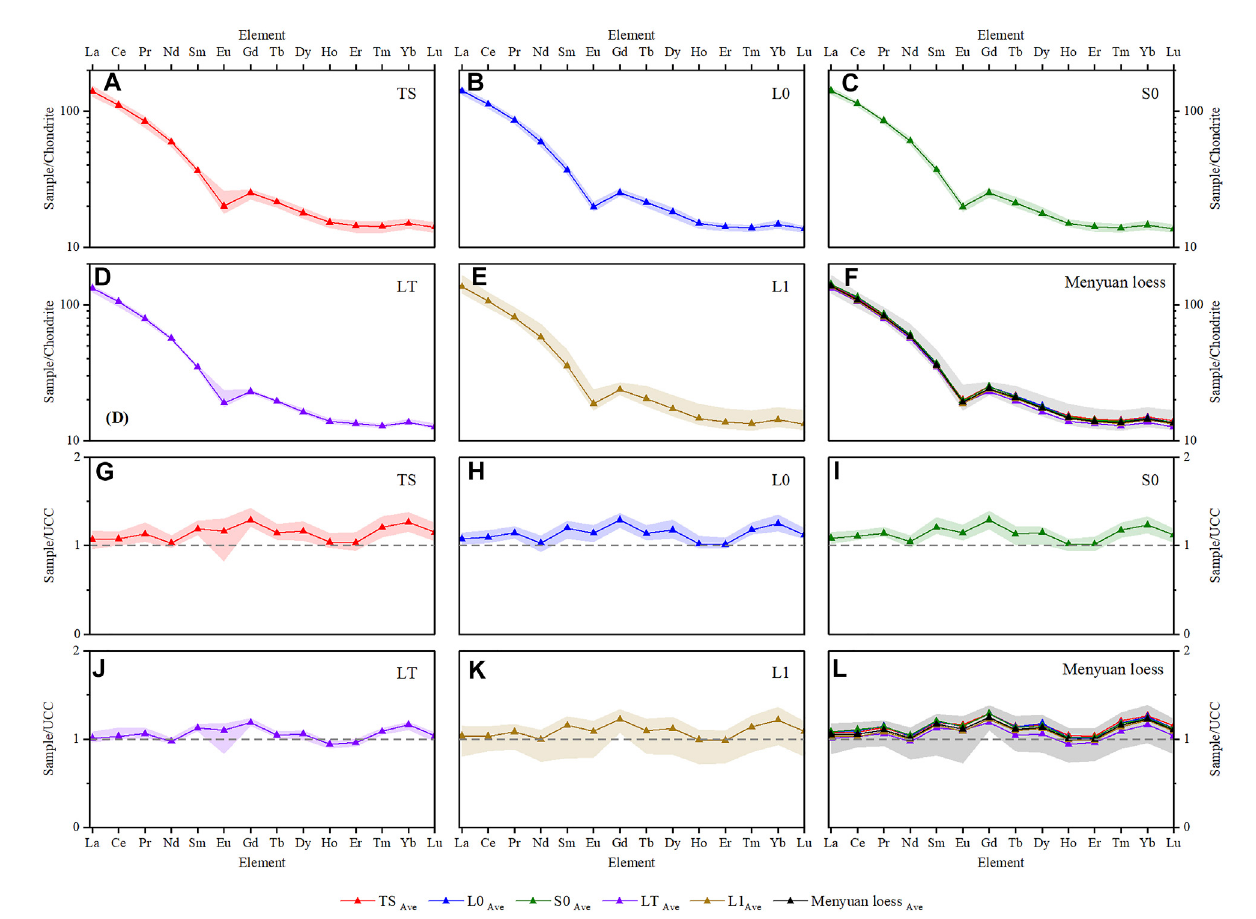
Chondrite-normalized distribution patterns of rare earth elements for TS (A) , L0 (B) , S0 (C) , LT (D) , L1 (E) and all (F) of sediments in Menyuan loess.UCC- normalized distribution patterns of rare earth elements for TS (G) , L0 (H) , S0 (I) , LT (J) , L1 (K) and all (L) of sediments in Menyuan loess.The dark lines are the averages of the layers, and the light areas are the ranges of the layers; the content displayed in each mini-graph is annotated in the upper left